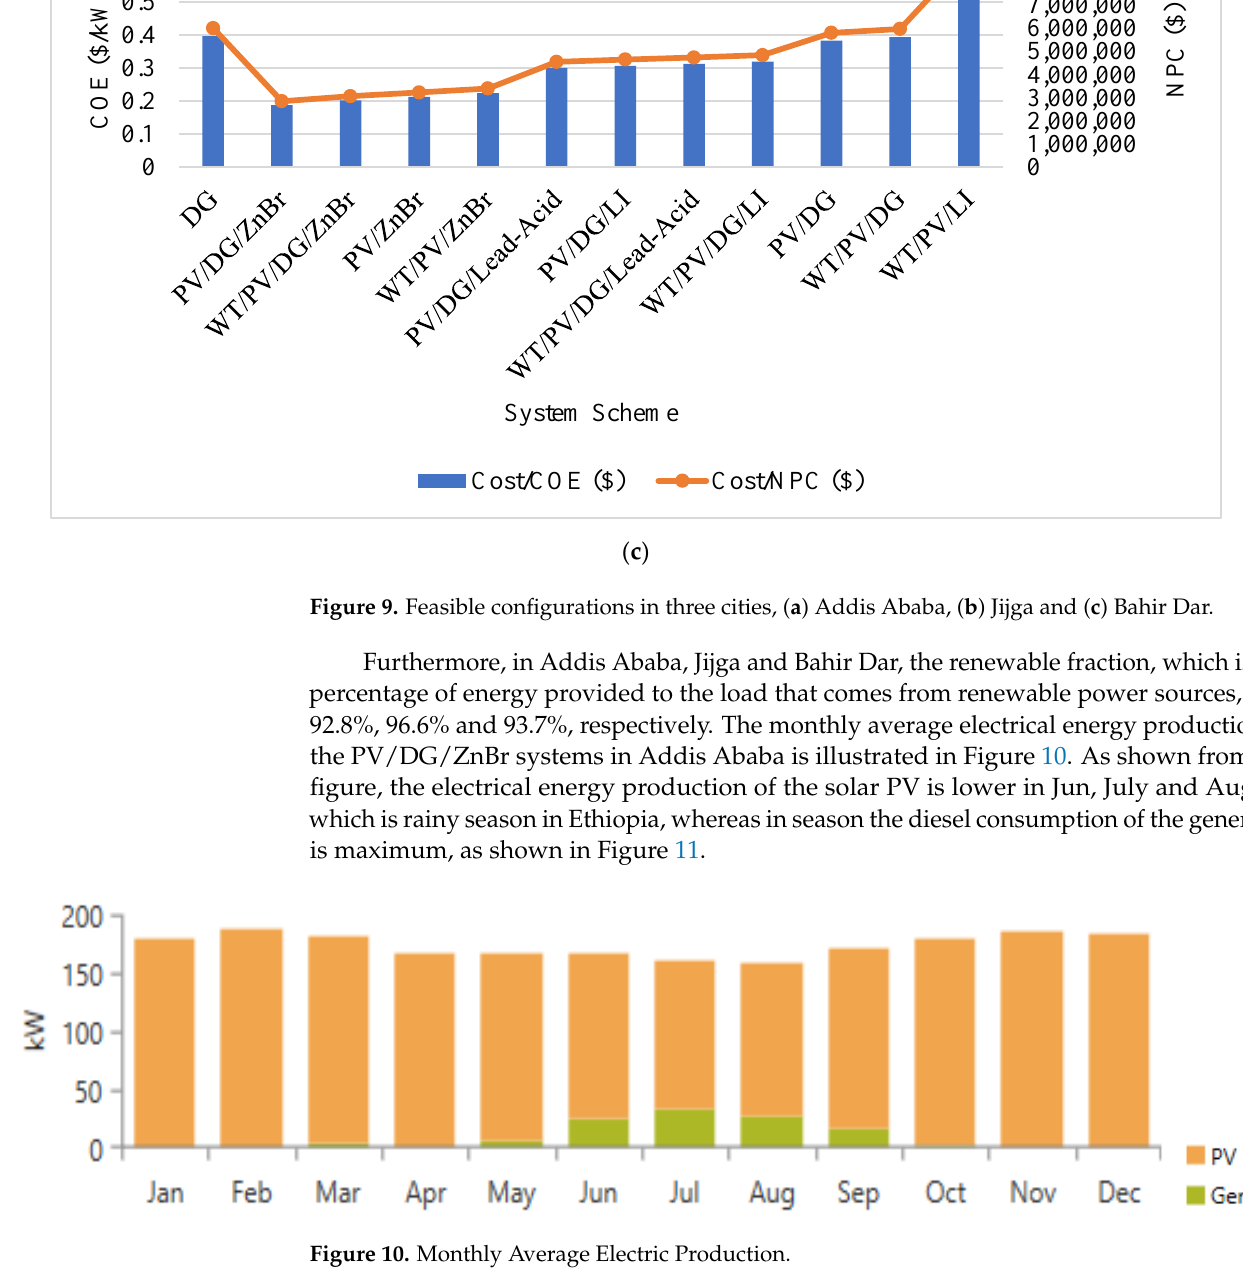
Figure 11. Diesel Consumption (L/hour). Additionally, Figure 12 shows the behavior of the best hybrid system in three cities over three days. PV systems fulfill energy demand and charge the battery bank during the day in all three graphs, starting to charge about 7:00 a.m. and stopping to discharge around 4:30 p.m. During the night, the battery bank assists the system in meeting energy demands. The environmental analysis part of the model involves the calculation of the avoided costs for CO 2 , PM and NO x . The obtained results of CO 2 emissions at Addis Ababa, Bahir Dar and Jijiga are 63,747, 55,489 and 29,726 kg/year with base case 885,349 kg/year, respec- tively. The modelling of the hybrid system and its sensitivity analysis was done using HOMER software. The results represent different combinations of components in hybrid systems, which are PV, WT, DG and battery. However, sensitivity variables must be taken into account in order to produce a rational hybrid renewable energy system solution. The solar radiation, wind speed and different chemistry of battery are the sensitivity variables considered for the optimal design of the system. It is used to find the optimal configura- tion among all the possible results that can be simulated to reach the least possible cost of energy.